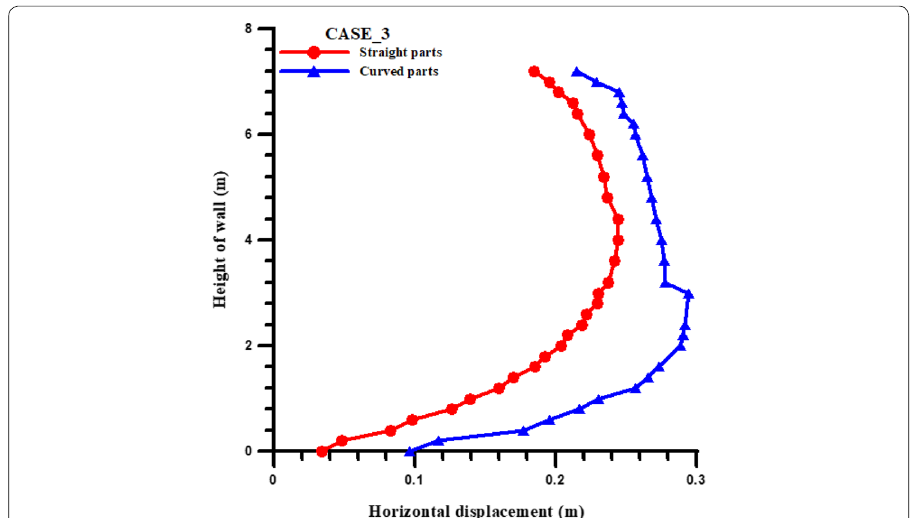
Fig. 13 Horizontal displacement comparison of straight and curved parts for Case 3